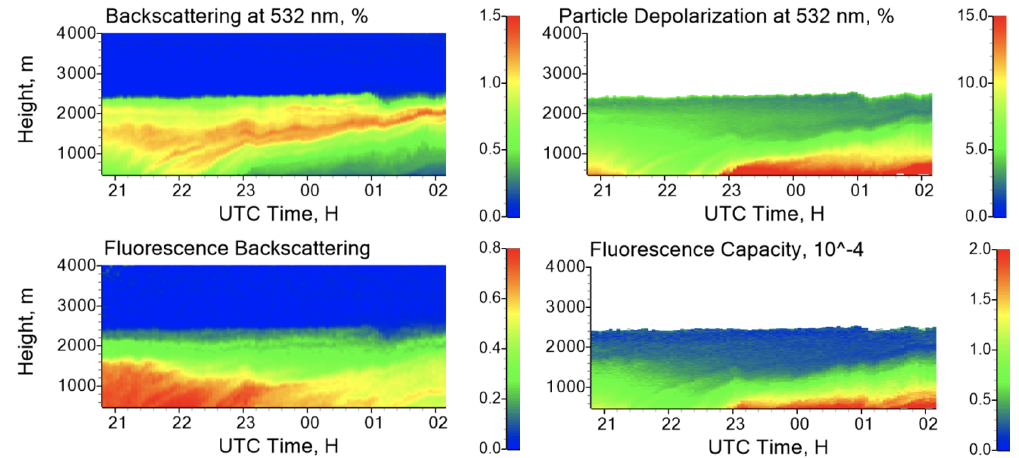
Figure 6. Spatiotemporal distributions of the backscattering coefficient β 532 , the fluorescence backscattering coefficient β F (in 10 − 4 Mm − 1 sr − 1 ), the particle depolarization ratio δ 532 , and the fluorescence capacity G F on the night of 30–31 May 2020. The values